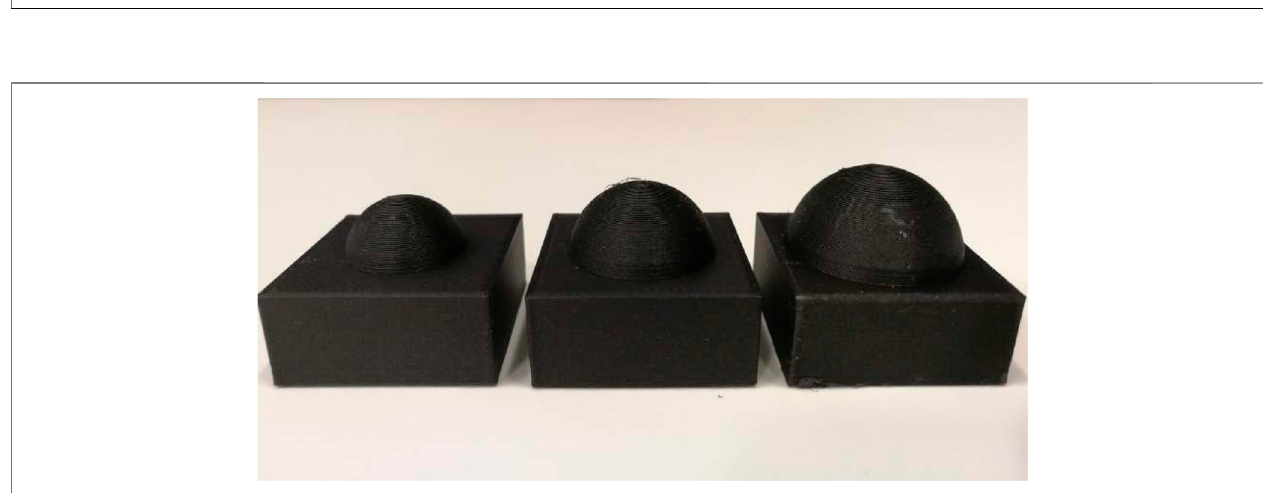
FIGURE17| Results oftherealexperiment. Maximum translational and rotational slippages observedover all attempts, forslow (leftcolumn) , moderate (middle column) and fast (right column) velocities, plotted against the 11graspingpoints. The successfuland failed attemptsare shown in blue and red bars respectively. The graphs show that the slower the pulling pro fi les is, the higher the success chance becomes.